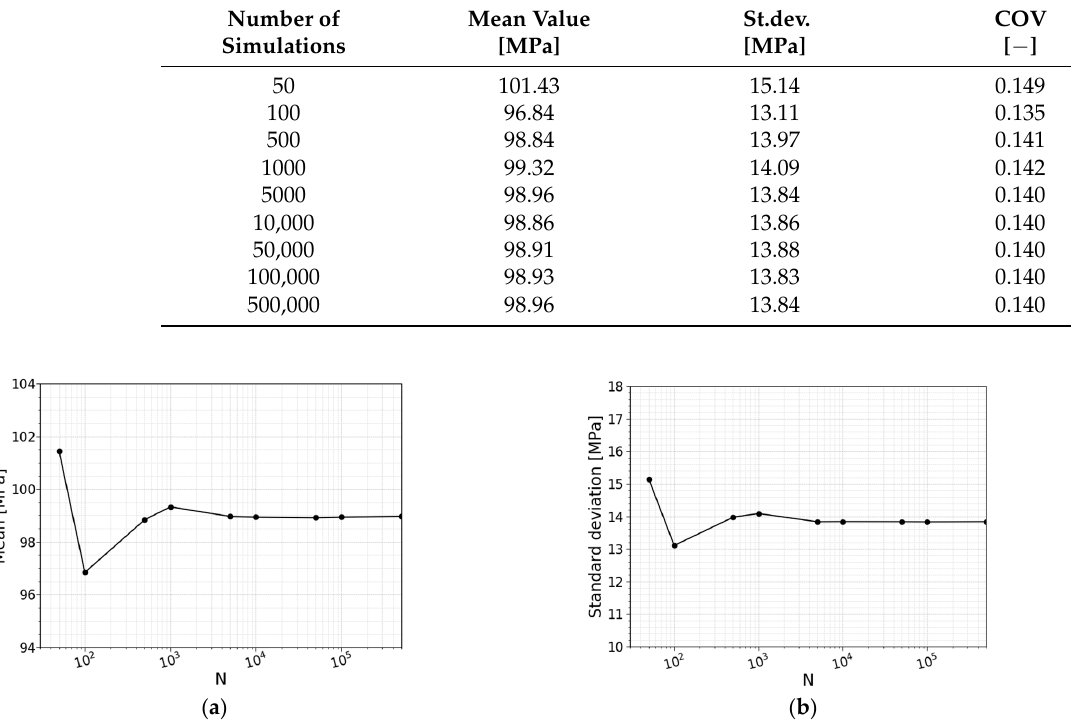
( b ) Figure 12. ( a ) PDF and ( b ) CDF of the convergence study. Table 3. Simulations needed for convergence at a given 𝑃 (cid:3044) . 𝑷 𝒒